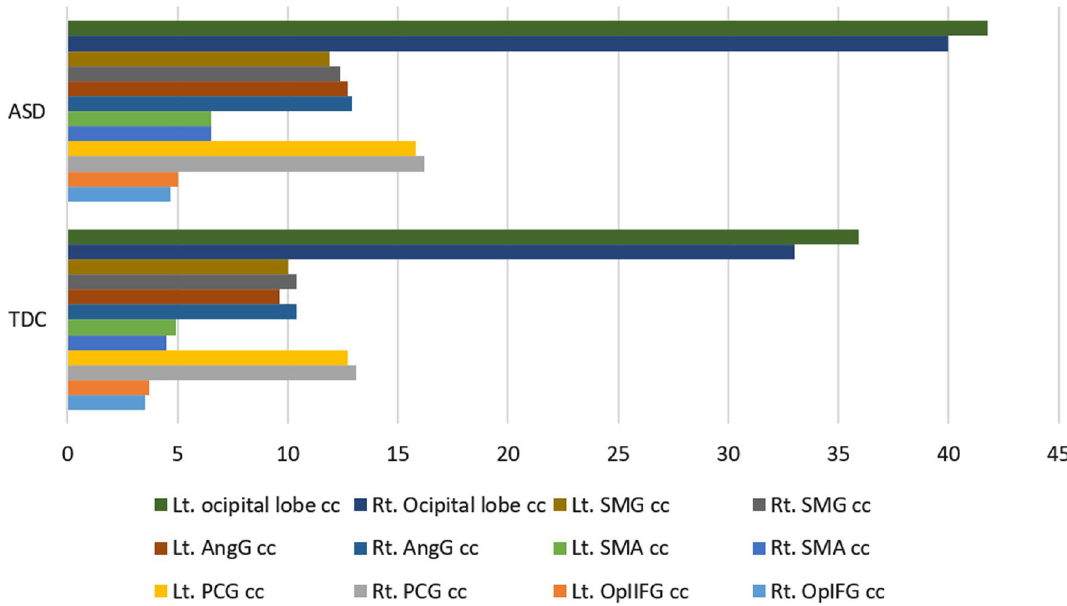
Fig. 2 Mean volume of different mirror neuron system components in TDC and ASD groups. SMG Supramarginal gyrus, AngG Angular gyrus, SMA Supplementry motor area, PCG Precentral gyrus, OpIFG Opercular inferior frontal